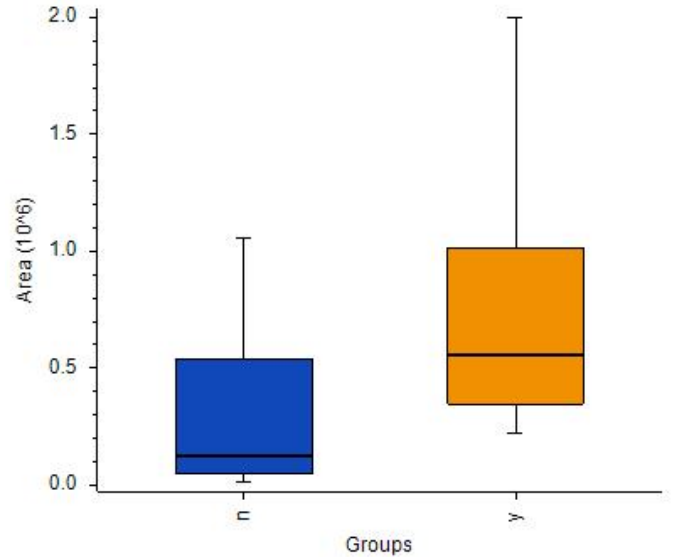
Figure 9. Box-and-whiskers plot for cystathionine in samples with detected 1p19q codeletion (orange) and 1p19q wild-type (dark blue). (Abbreviations: N–1p19q wild-type; Y–1p19q codeleted)